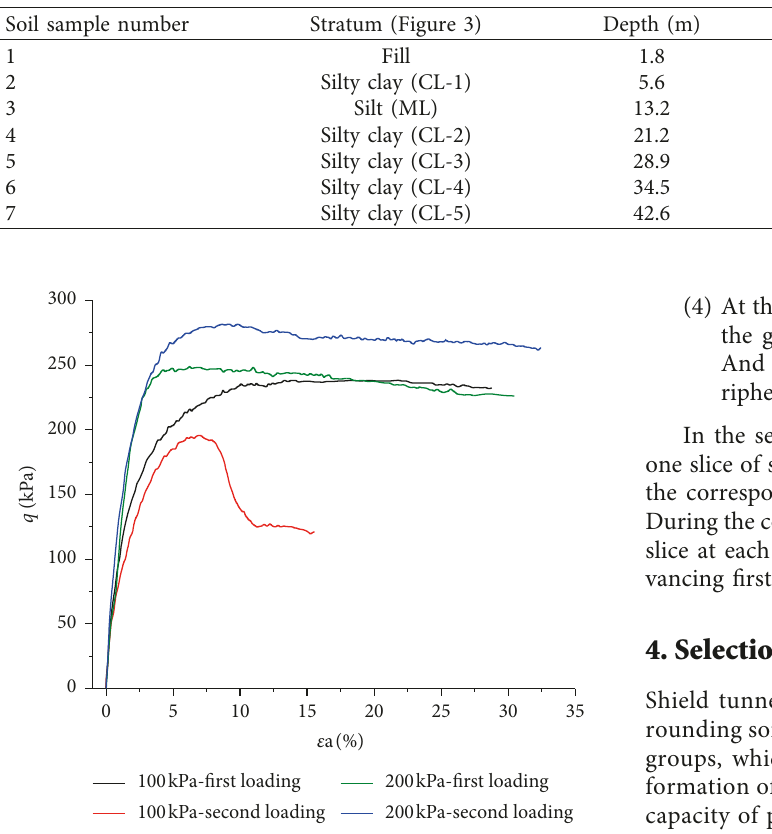
Table 1: Shear strength parameters of triaxial tests.